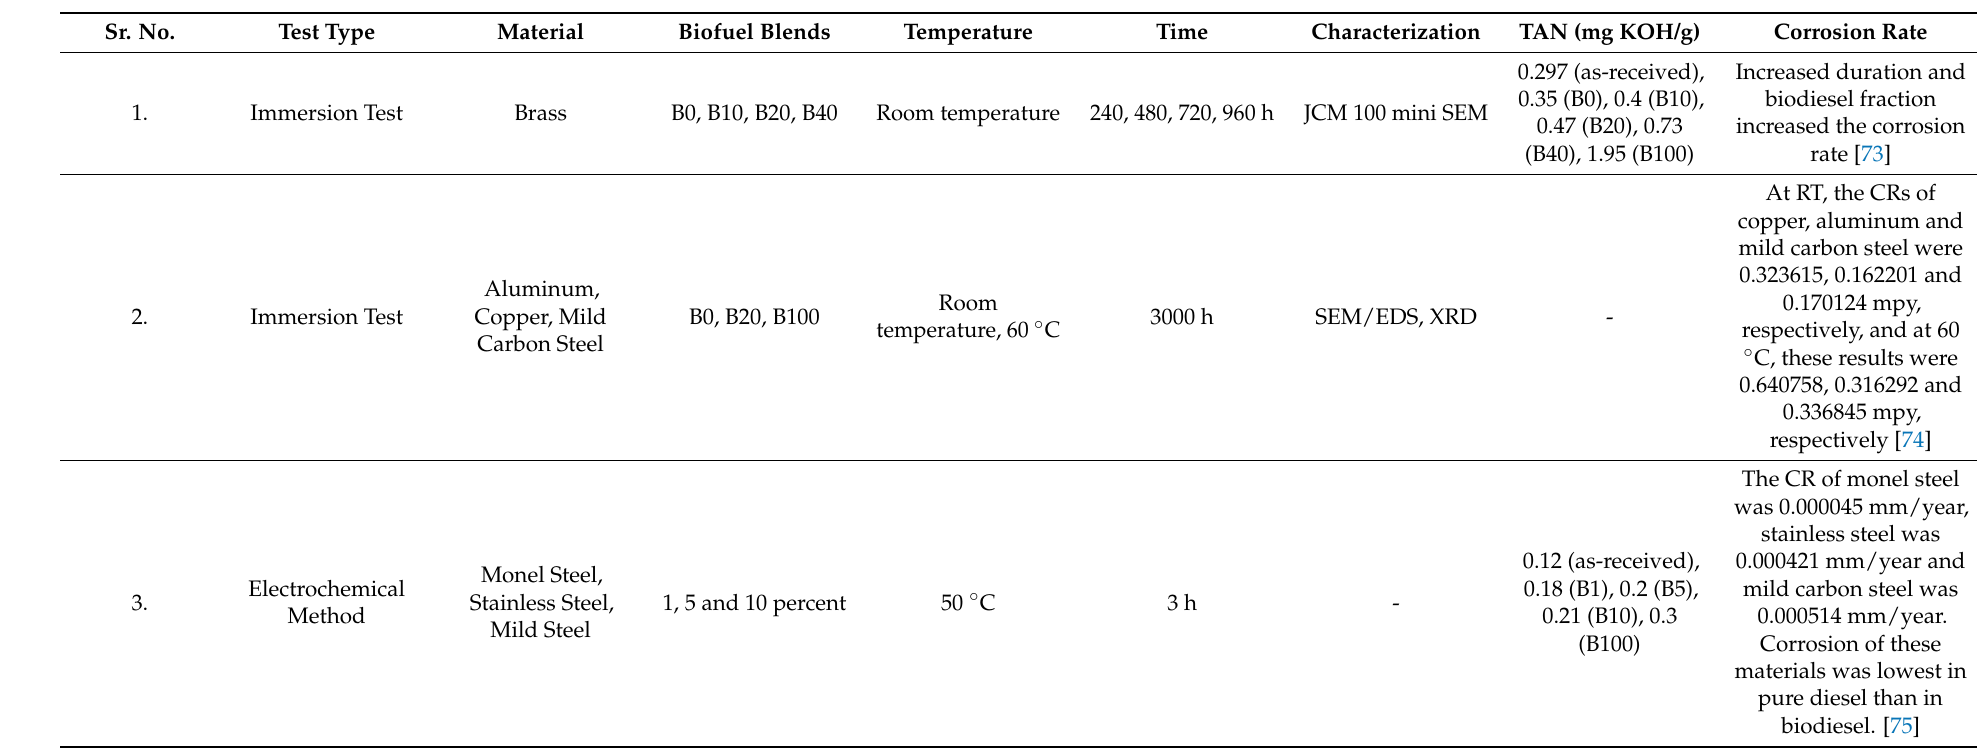
Table 4. Summary of corrosion studies using sunflower